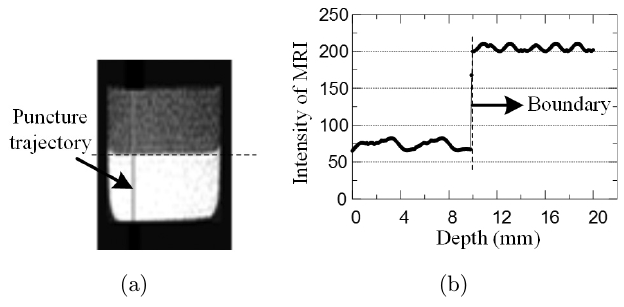
Fig. 2. Boundary of MR image. (a) The MR image of a two- layer model (b) the intensity of MR image along the trajectory.